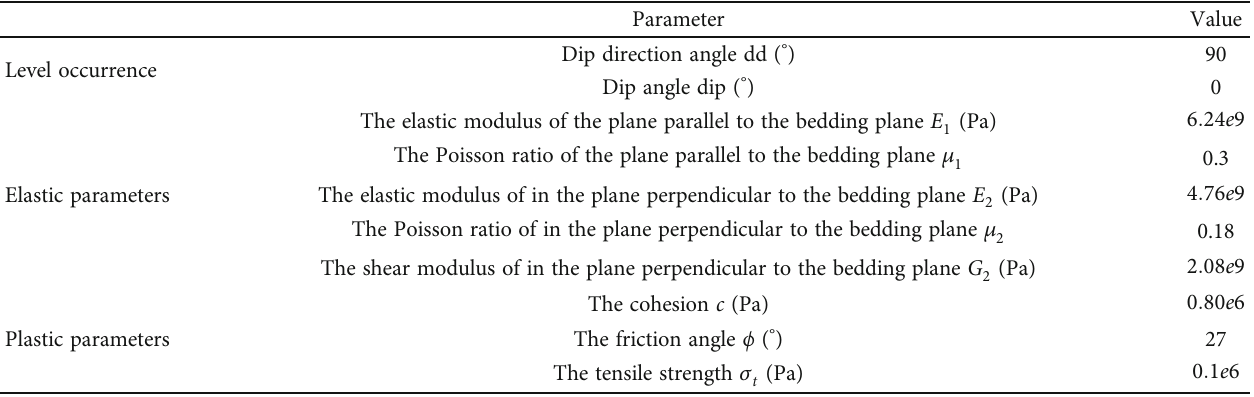
Table 4: Calculation parameters of the AN-MC constitutive model.